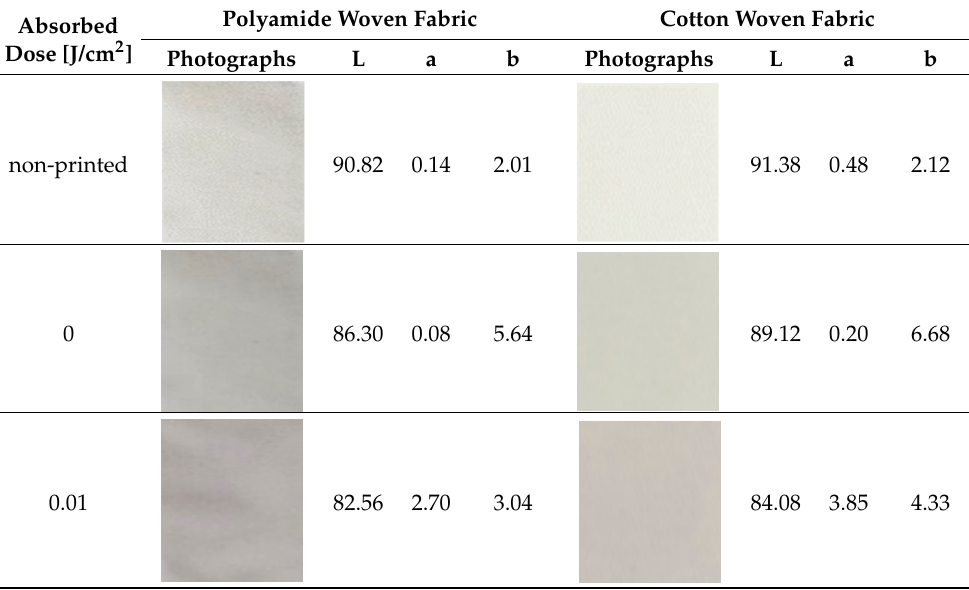
Table 4. The colour change of polyamide and cotton fabrics printed with NBT-Pluronic F-127 hydrogel and irradiated with UVB radiation.